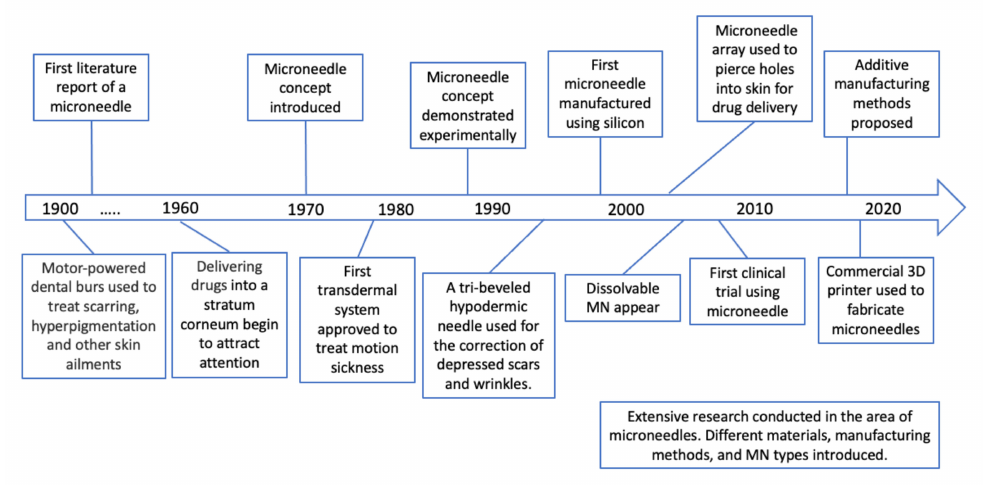
Figure 4. Historic timeline for MN technologies.